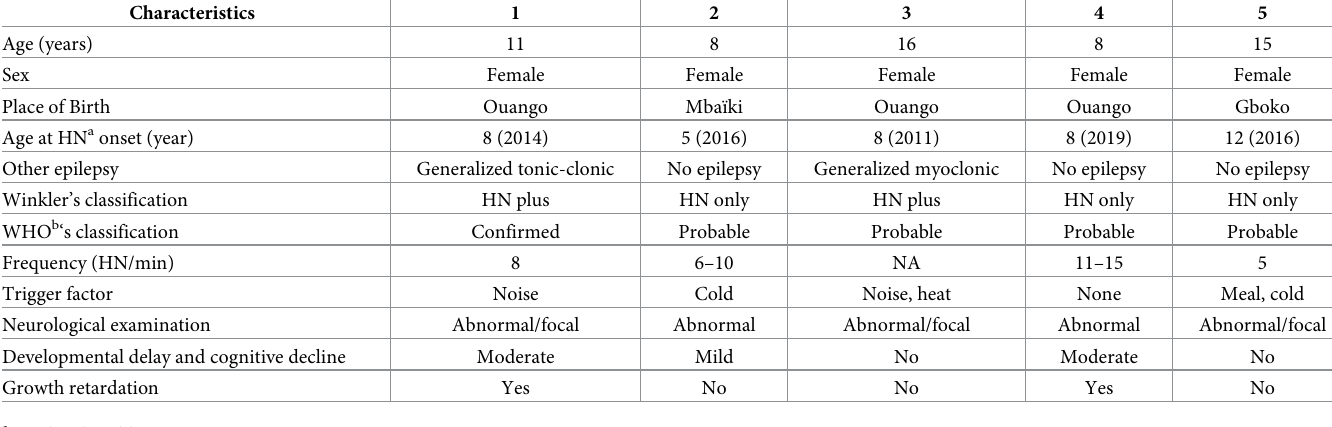
Table 1. Socio-demographic and clinical characteristics of Patients with Nodding Syndrome, Central African Republic, 2019.